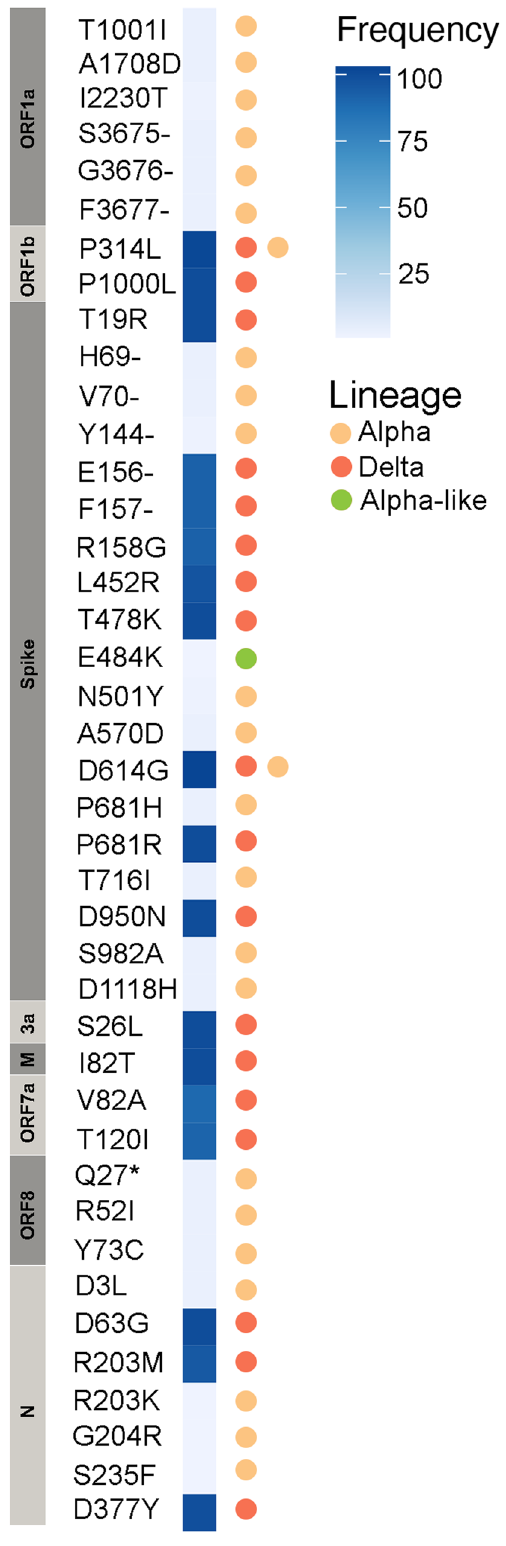
Figure 2. Heat map of frequency of amino acid mutations found in 103 SARS-CoV-2 genomes sequenced as part of this study from patients in Kyiv, Ukraine, in July and December 2021. Mutations associated with variant of concern lineages Alpha and Delta are